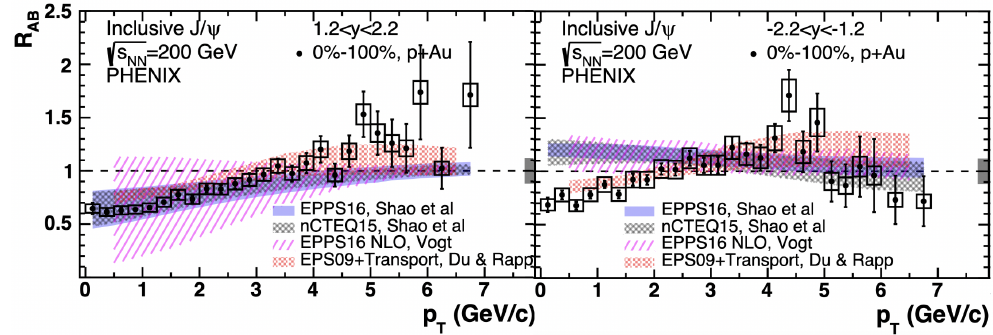
Figure 6. J / ψ nuclear modification as a function of p T in p + Au collisions at forward ( left ) and backward ( right ) rapidity for 0–100% centrality [41]. The data are compared with different theoretical models described in the text. Reprinted with permission from American Physical